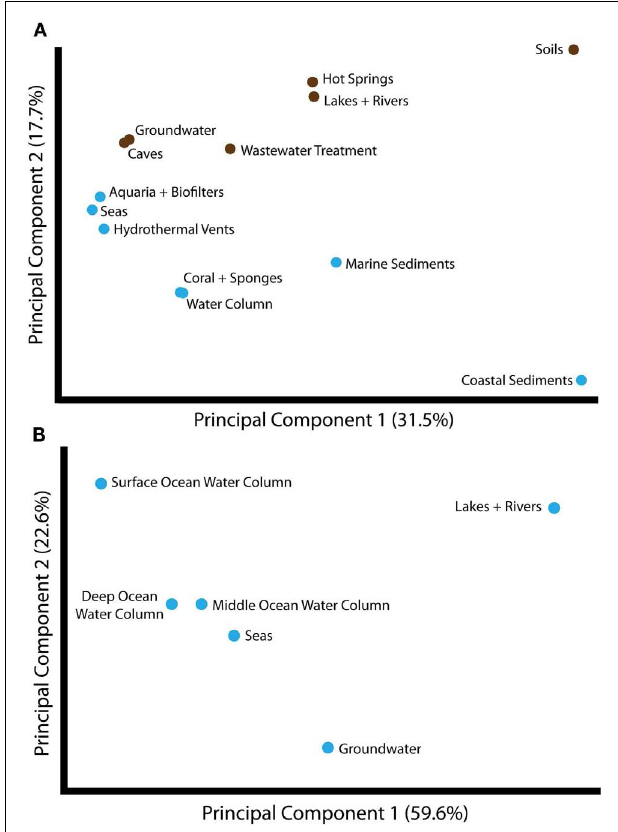
FIGURE 2 | Principal components analysis of unweighted Unifrac distances between different groups of amoA sequences, as categorized by habitat from which the sequences were isolated. (A) Unifrac analysis of amoA sequences from all habitats annotated in the complete amoA sequence dataset.The first two principal components account for 49% of the variation between all habitats. Unifrac analysis was conducted based on the maximum likelihood tree shown in Figure 1 . Habitats are colored as either marine (blue) or freshwater/terrestrial (brown). (B) Unifrac analysis of amoA sequences from aquatic environments only. A maximum likelihood tree was computed for all unique sequences from the indicated habitats using RAxML and analyzed by Unifrac as above.The major principal component correlates with salinity.